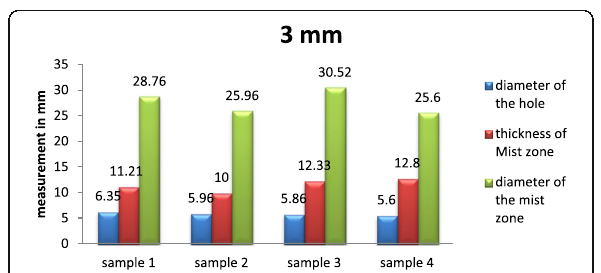
Fig. 4 Graphical Representation of Measurements for 3 mm